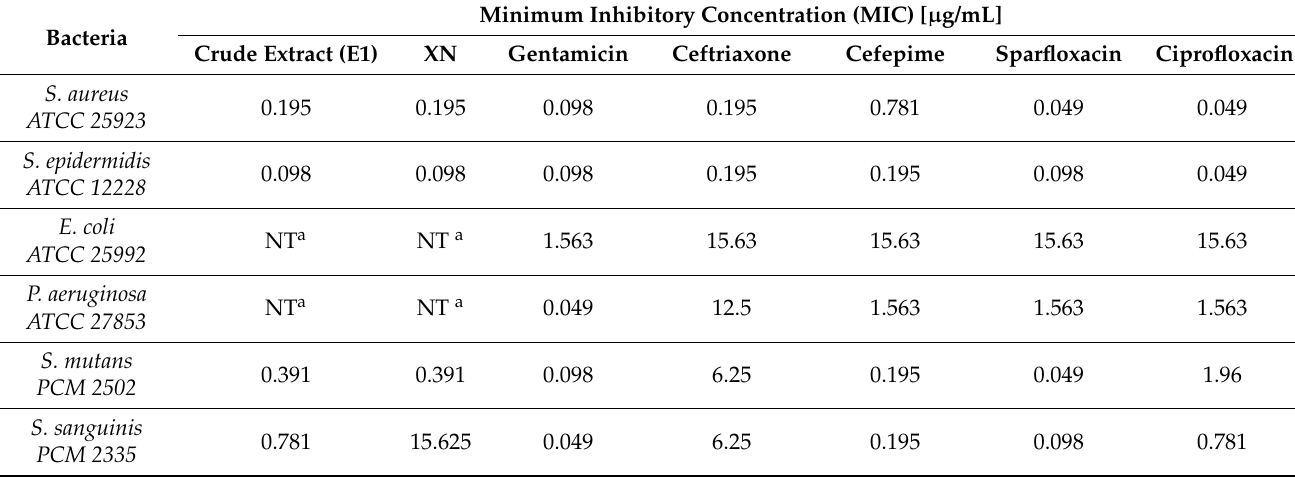
Table 4. Minimum inhibitory concentration (MIC) of compounds from Marynka hop variety and selected antibiotics.